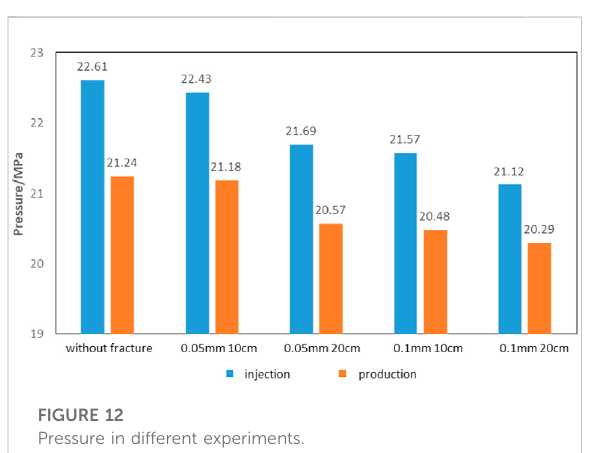
FIGURE 14 Main components of the oil phase at the moment when CO 2 was